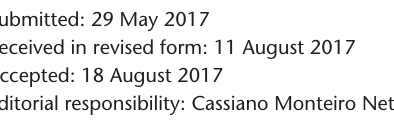
Table S2. Vertical distributions of the mean, standard de- viation (SD), relative abundance (RA), and occurrence fre- quency (OF) of the copepod species found in Campos Basin, during the dry